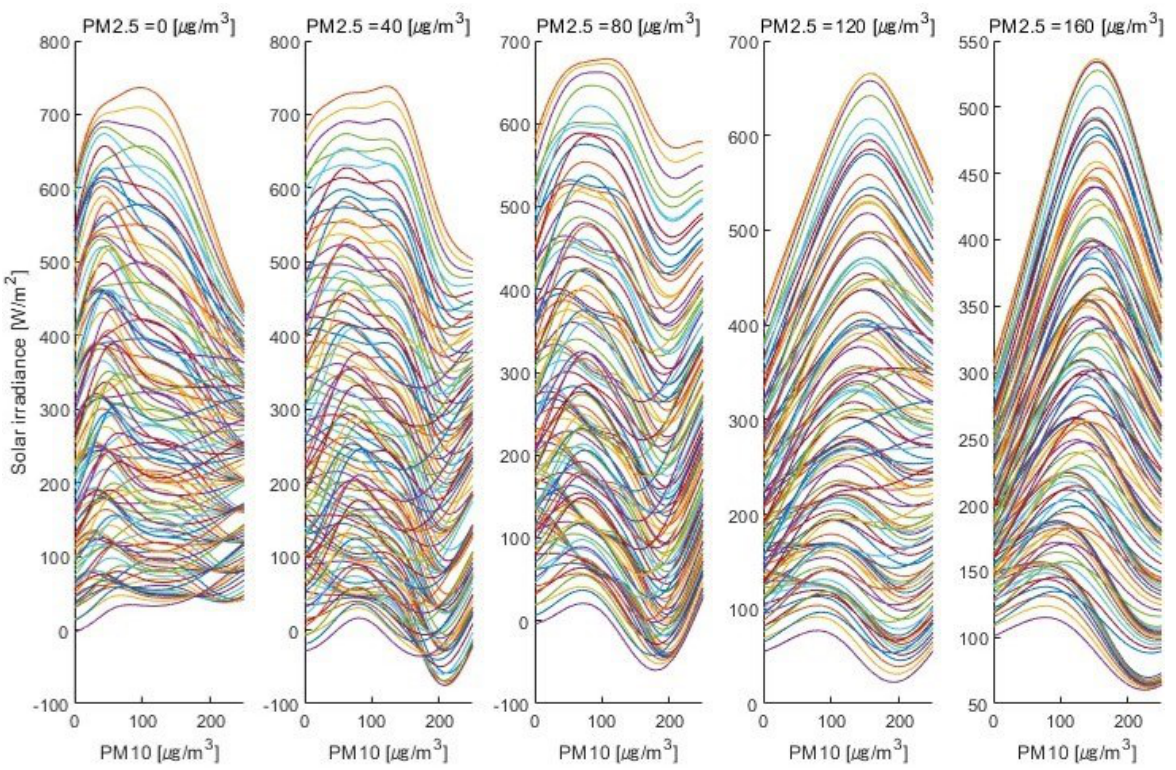
Figure 7. Neural network analysis on the influence of particulate matter (PM10) to the level of solar irradiation measured on the ground.